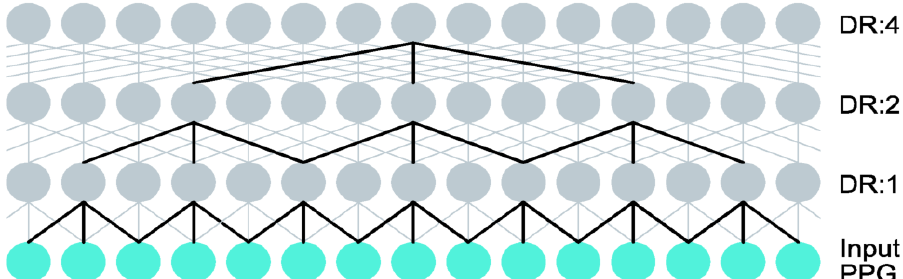
Figure 6. The receptive field of a neuron in a three-layer dilated convolution network is illustrated with bold lines. Note how the dilation rate (DR) is doubled at every layer. Our model is deeper than this illustration as it contains four additional